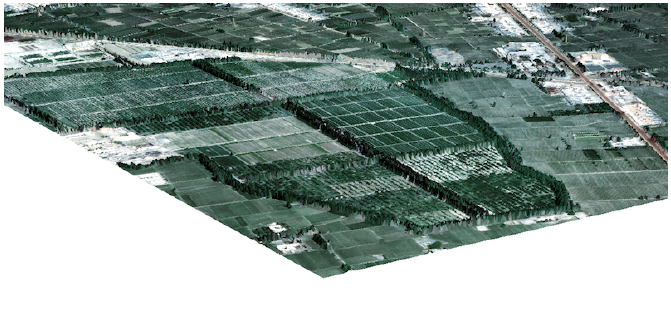
Figure 2. Example of 3-D rendering of the South-West part of the Yingke area obtained by combination of the LIDAR Digital Surface Model and the high resolution image simultaneously acquired by the CCD camera installed together with the LiteMapper